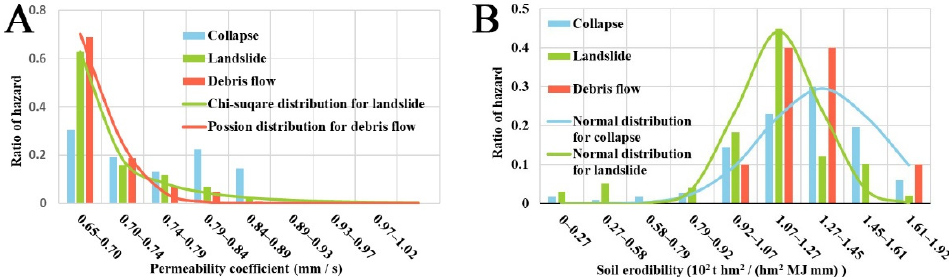
Figure 6. The relationship between permeability coefficient and number of hazards in Northern Shaanxi ( A ) and soil erodibility factor and number of hazards in Southern Shaanxi ( B ). We adopted the Random Forests technique to quantify the contribution of potential impact factors. AUC < 0.7 indicates a poor performance for predictions, 0.7 < AUC < 0.8 represents medium, 0.8 < AUC < 0.9 and AUC > 0.9 represents good and excellent perfor- mances, respectively [26]. In general, the Random Forests technique was applicable in Shaanxi province (Figure 7). For instance, the AUC values for collapses in SS and NS were 0.838 and 0.794, respectively. The AUC value for landslides in NS was 0.833 but was rela- tively low in SS (0.71). The AUC values for debris flows in SS reached 0.841; however, this method was not appliable to NS due to the low number of debris flows.